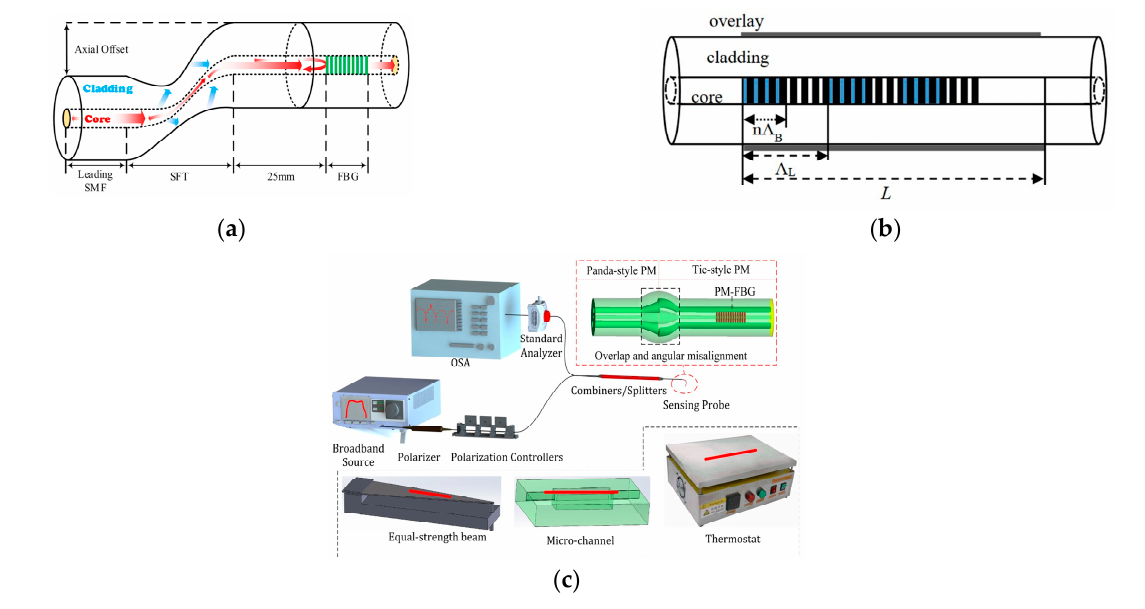
Figure 10. ( a ) Schematic diagram of the proposed RI sensor [89]. ( b ) Superimposed coated LPFG and FBG structures [90]. ( c ) Schematic configuration and experimental setup of the sensing probe [92]. Table 7. Summary of hybrid